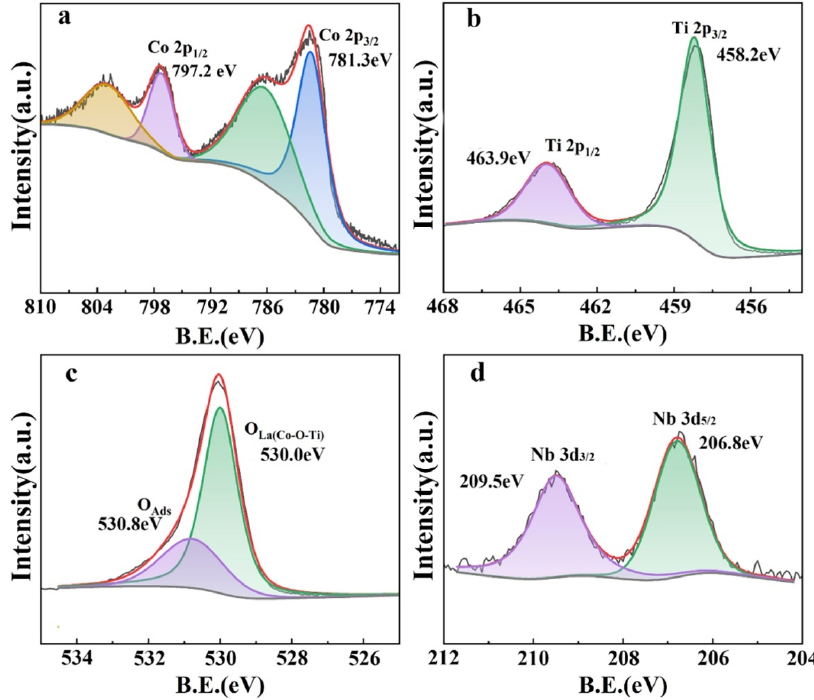
Figure 4. XPS spectra of S1. ( a ) Co 2p, ( b ) Ti 2p, ( c ) O 1s, and ( d ) Nb 3d.